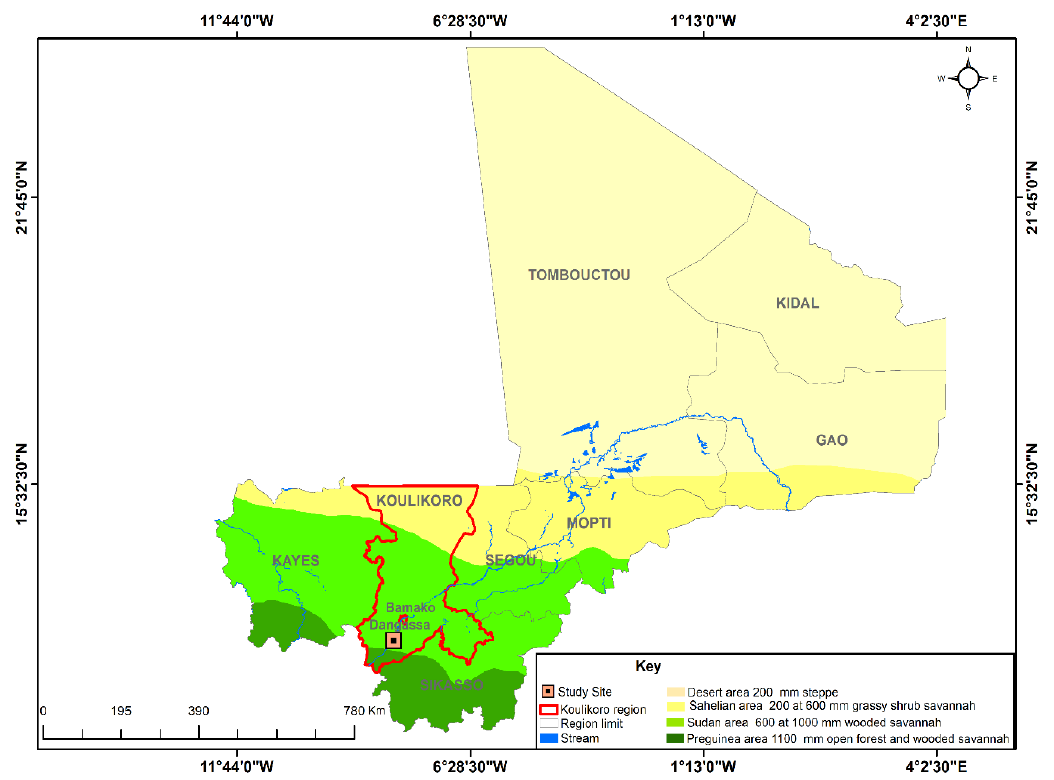
Figure 1. Map of Mali indicating the location of Dangassa a. a The study site is indicated by a black point. The map has been made based on the cartography of Mali, the mean normalized difference vegetation index (NDVI) reported was downloaded as a raster from NASA Giovanni for the time period 11/01/2012–31/12/2017. Source: ICER Mali/MRTC-OKD/DEAP/GIS Unit, 2020.